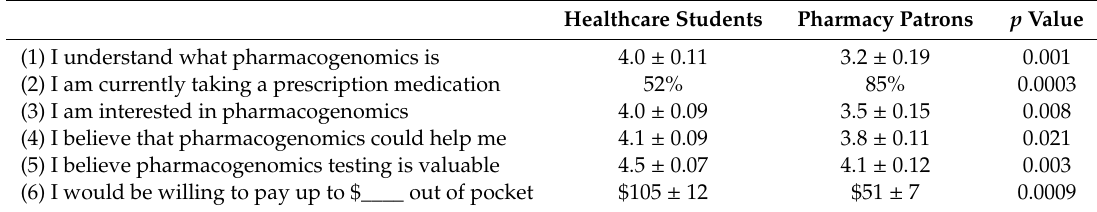
Table 2. A comparison of survey responses between two cohorts using a Mann–Whitney U test.